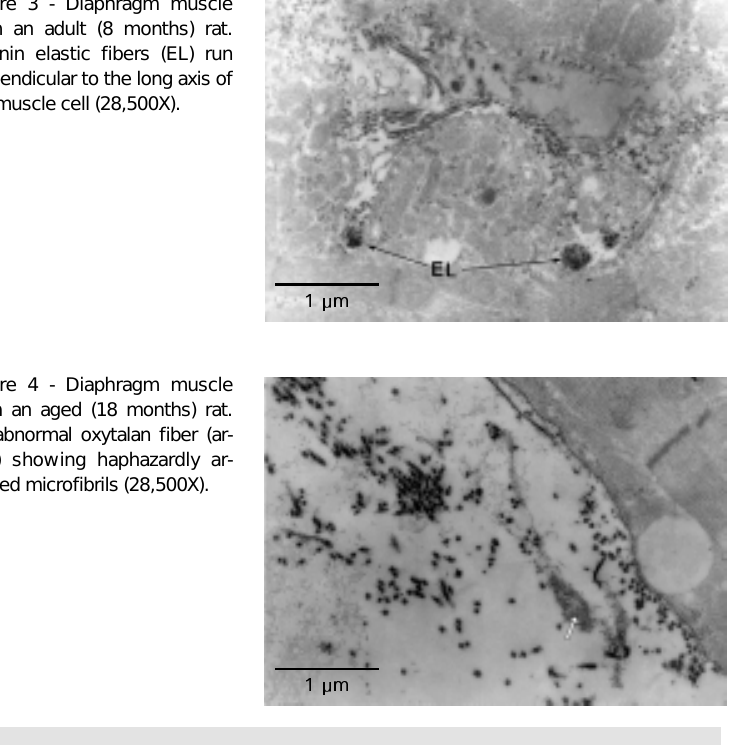
Table 1 - Linear density (LV) of the elastic fiber system. Values are reported as the mean ± SD (x 10 -3 µm -2 ); N, number of rats. WO, Weigert- oxone; W, Weigert; V, Verhoeff: methods for staining elastic fibers. The data on LV of elastic fiber concentration in the tissue were analyzed by ANOVA correlating them with age.